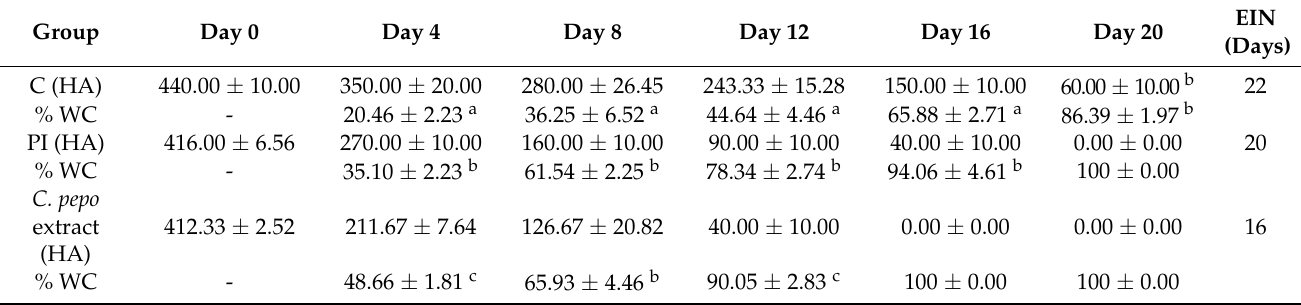
Table 5. Effect of C. pepo extract on circular excision wound model.